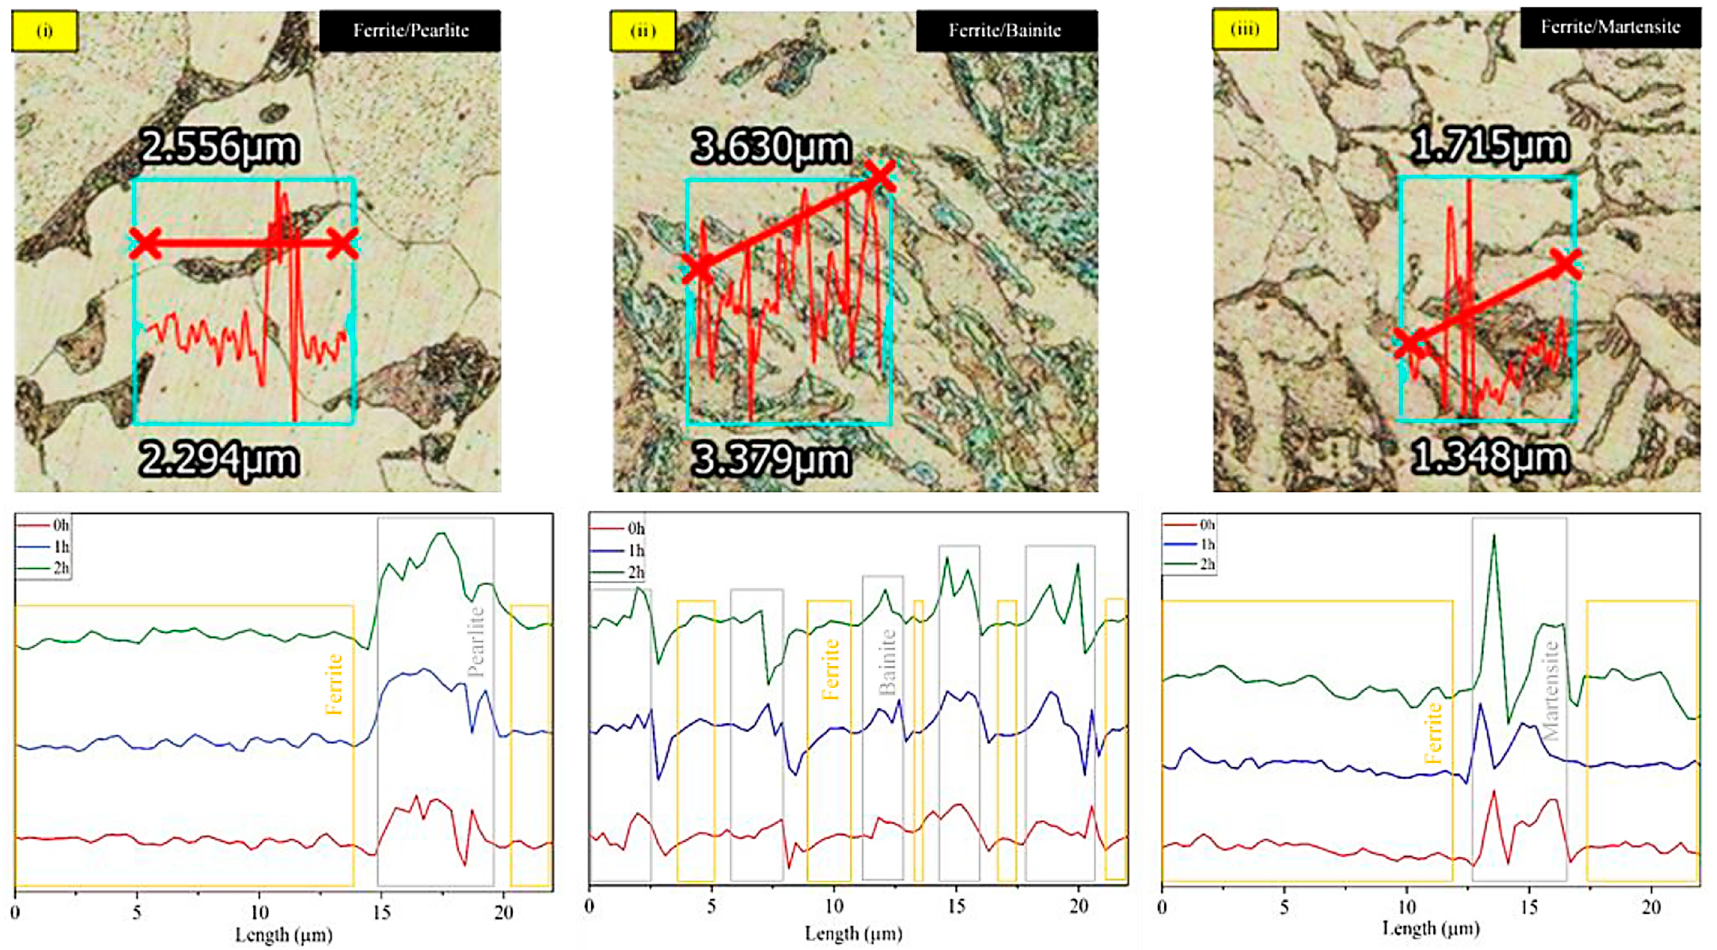
Figure 6. 3DLSCM imaging of different corrosion behavior from each phase through line scan profile for (i) DS ferrite/pearlite, (ii) TS ferrite/bainite, and (iii) TS ferrite/martensite in immersion of 3.5 wt. % NaCl solution.